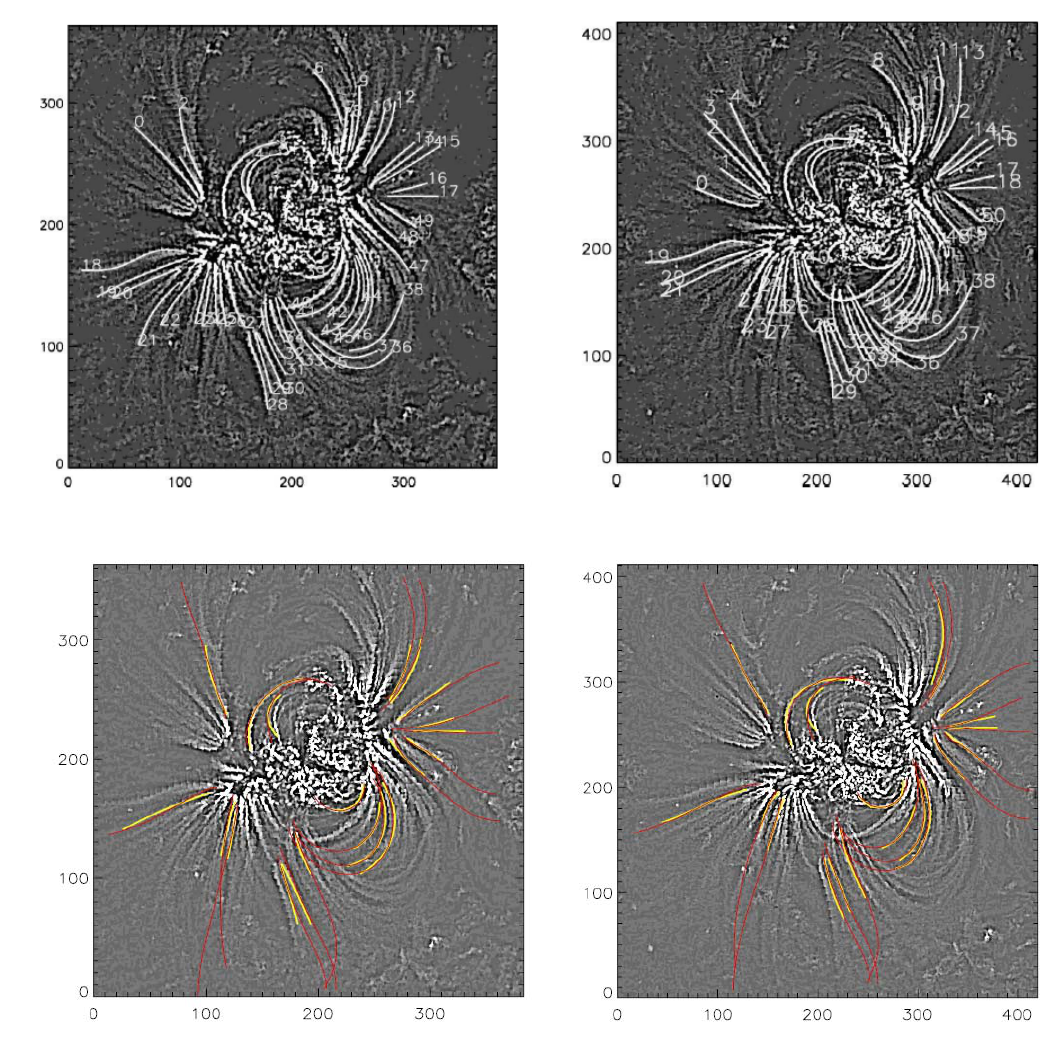
Fig. 2. Top: Contrast enhanced EUVI images from STEREO-B (left) and A (right) of the NOAA AR 0960 on 8 June 2007. The individual loops (enumerated white curves) have been extracted by a semi-automatic feature recognition tool as described in Inhester et al. (2008). Please note that equal numbers do not imply a correspondence across the images. Bottom: Some selected coronal loops (yellow) with their best fit magnetic field line (red). The separation angle between the spacecraft was 12 ◦ . [The top figures have been published originally in Feng et al. (2007b) figure 1.]